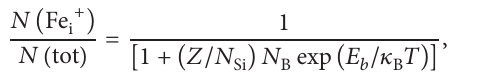
to N (Fe i + ) as the Fermi level is below the defect level 𝐸 V + 0.39 eV of Fe 0/+ , for all temperatures studied [7]. It can be seen from Figure 2 that the value of N (Fe i + )/ N (tot) increases with increasing temperature for both samples. But the increase rate of N (Fe i + )/ N (tot) for the uncompensated material is larger than that for the compensated one if temperature is above 100 ∘